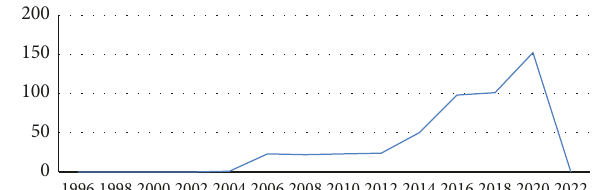
Figure 32: Article distribution by years for qualitative systematic review